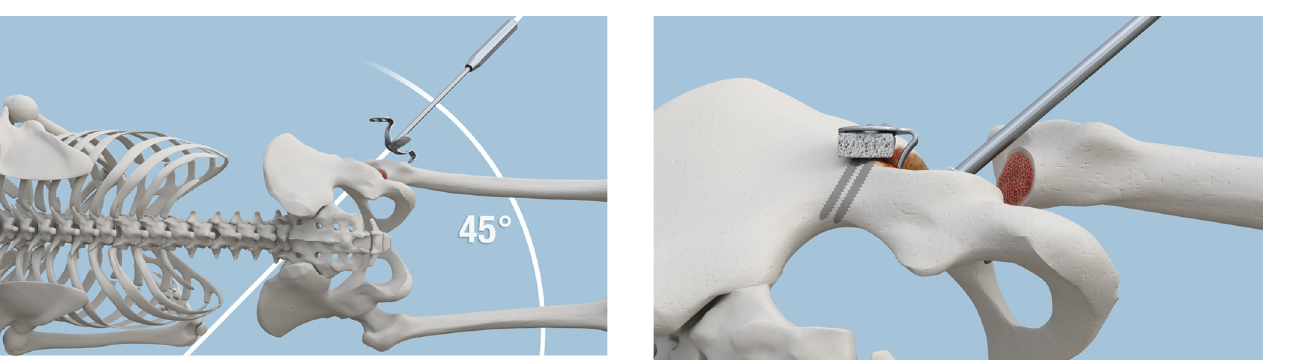
Figure 6. The superior graft in place.